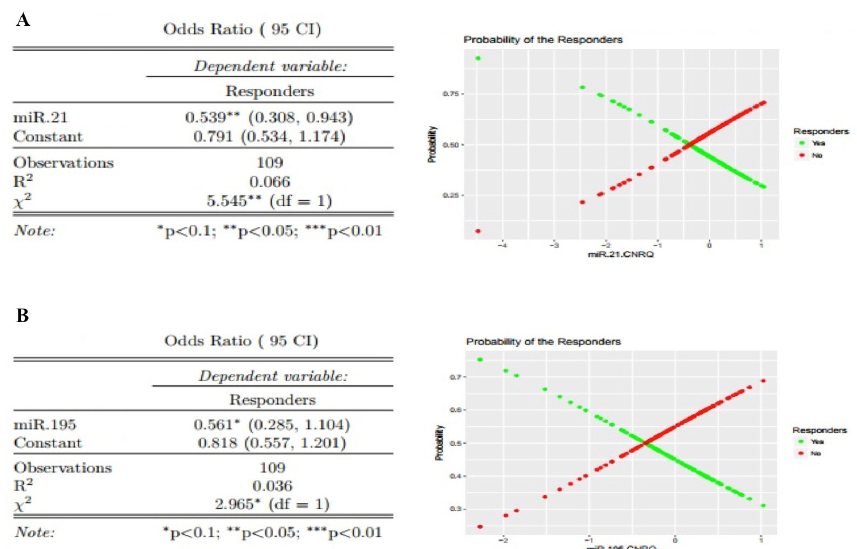
Figure 3. Univariate analysis of miRNA-21 and miRNA-195 level as an independent predictor of response. ( A ) For miRNA-21 every unit increase miRNA-21, the odds ratio of being a non-responder relative to a responder is 1.86 (1 / 0.538) times higher. ( B ) miRNA-195—with every unit increase in miRNA-195, the odds ratio of being a non-responder relative to a responder is 1.78 (1 / 0.561) times higher. Observations = n (indicated for